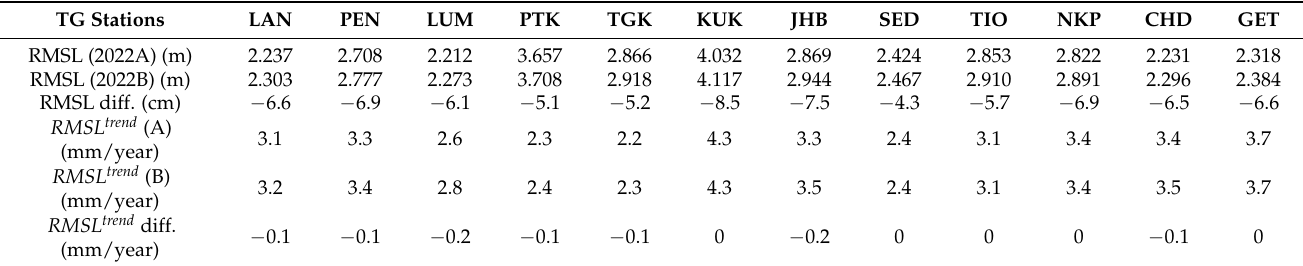
Table 3. Differences in tide gauge relative mean sea level (RMSL) and its trends ( RMSL trend ) between averaging and time-series techniques.